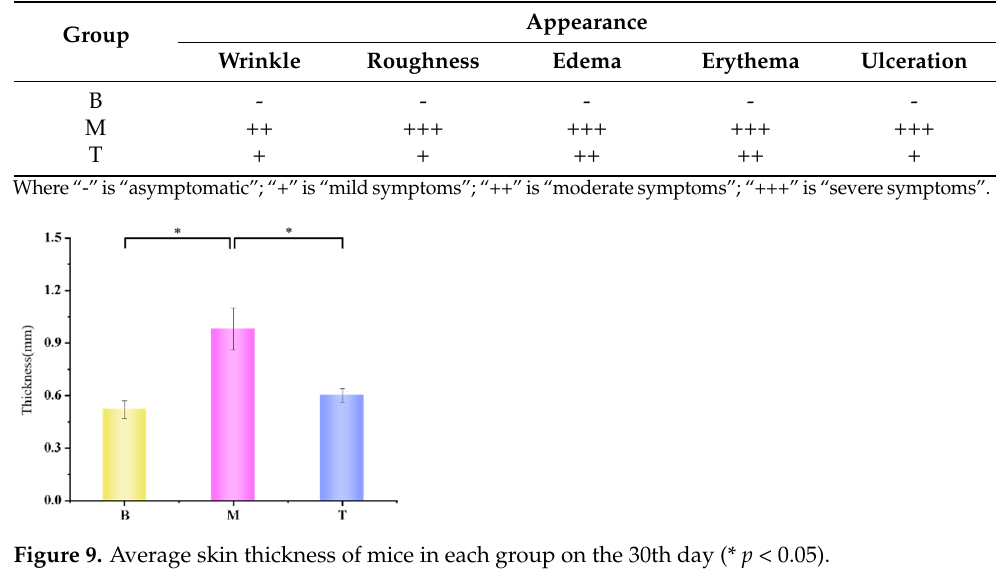
Table 3. Skin appearance evaluation standard of mice.